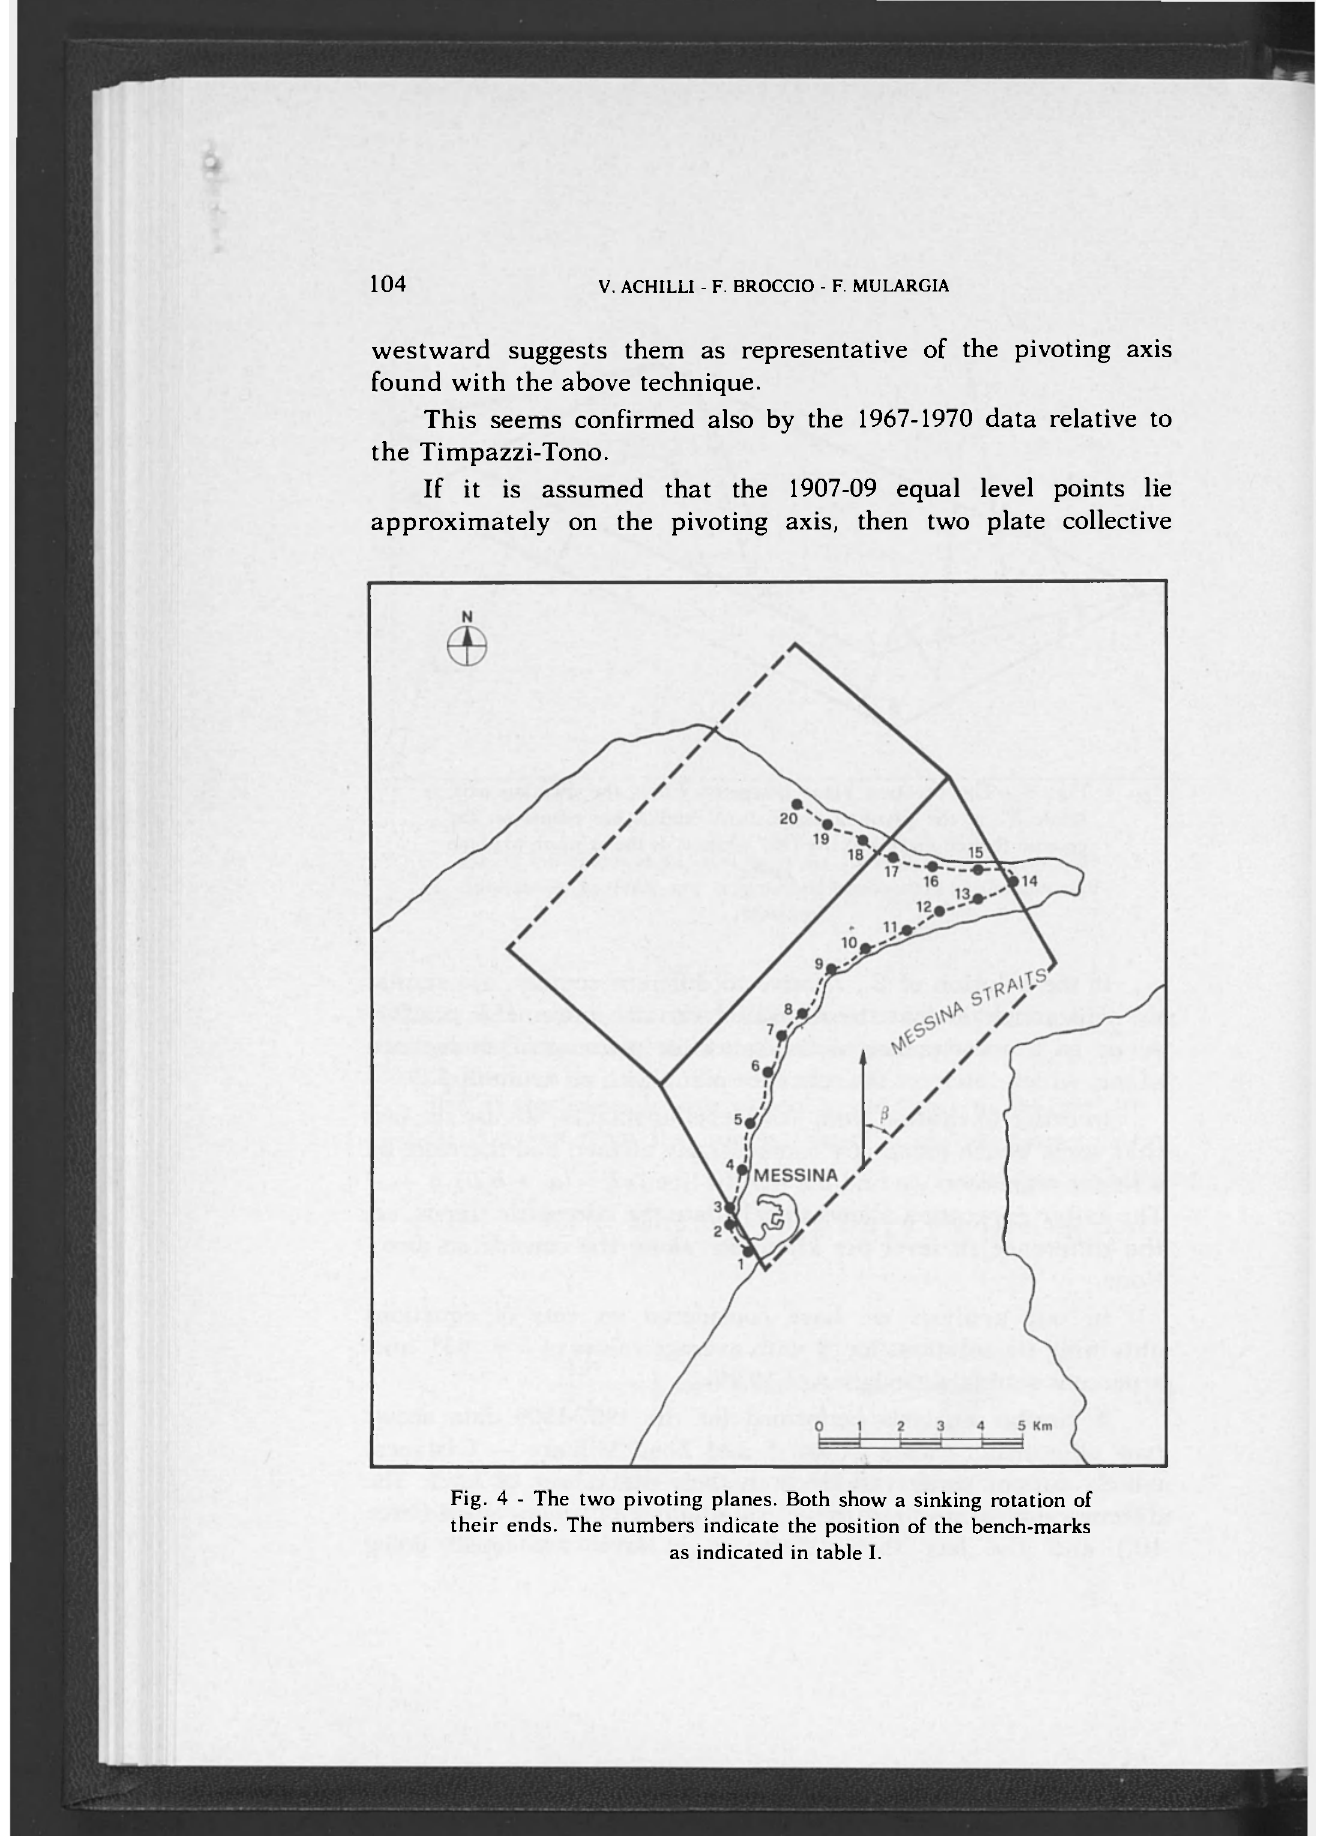
Fig. 4 - The two pivoting planes. Both show a sinking rotation of their ends. The numbers indicate the position of the bench-marks as indicated in table